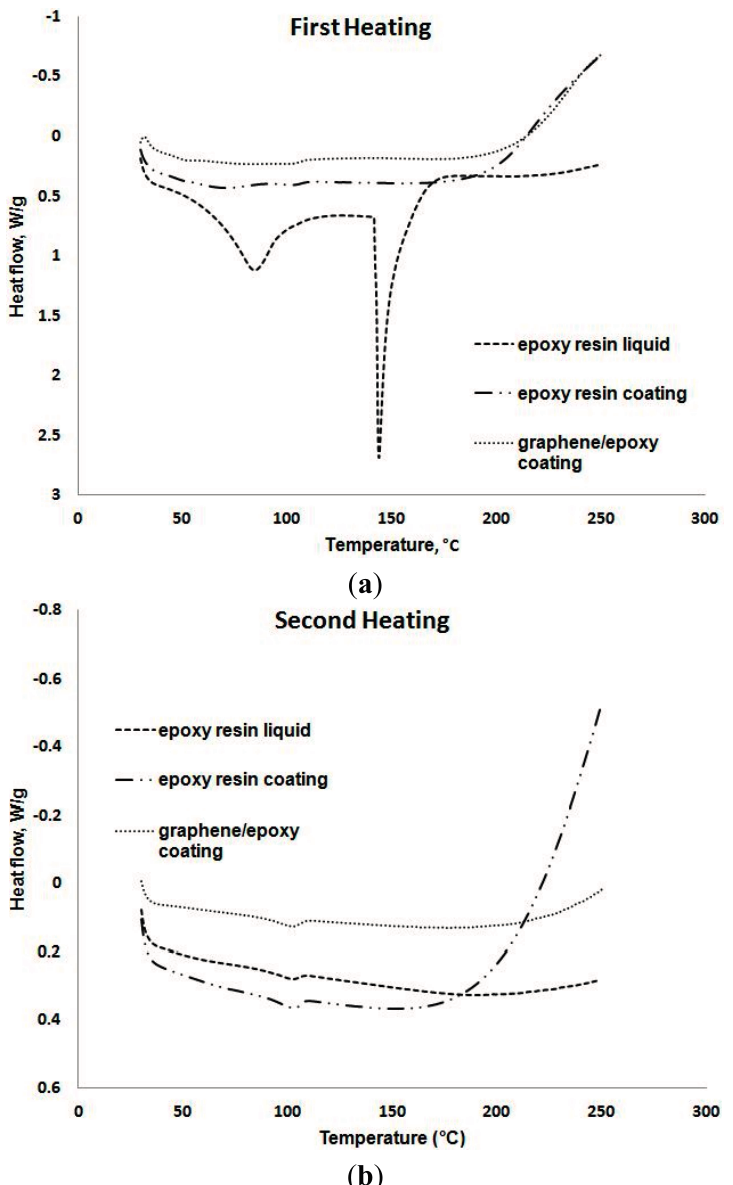
Figure 7. DSC measurements: first heating ( a ) and second heating ( b